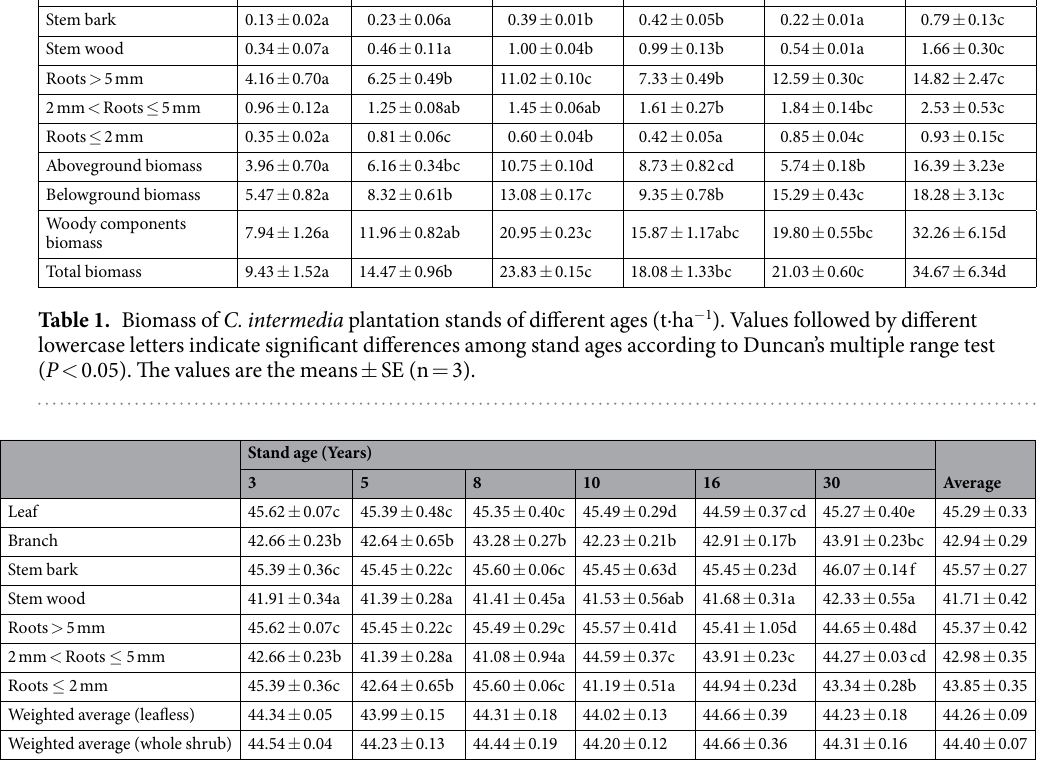
Table 2. Biomass carbon concentrations for C. intermedia plantation stands of different ages (%). Values followed by different lowercase letters indicate a significant difference among the components according to Duncan’s multiple range test ( P < 0.05). The values are the means ± SE (n =